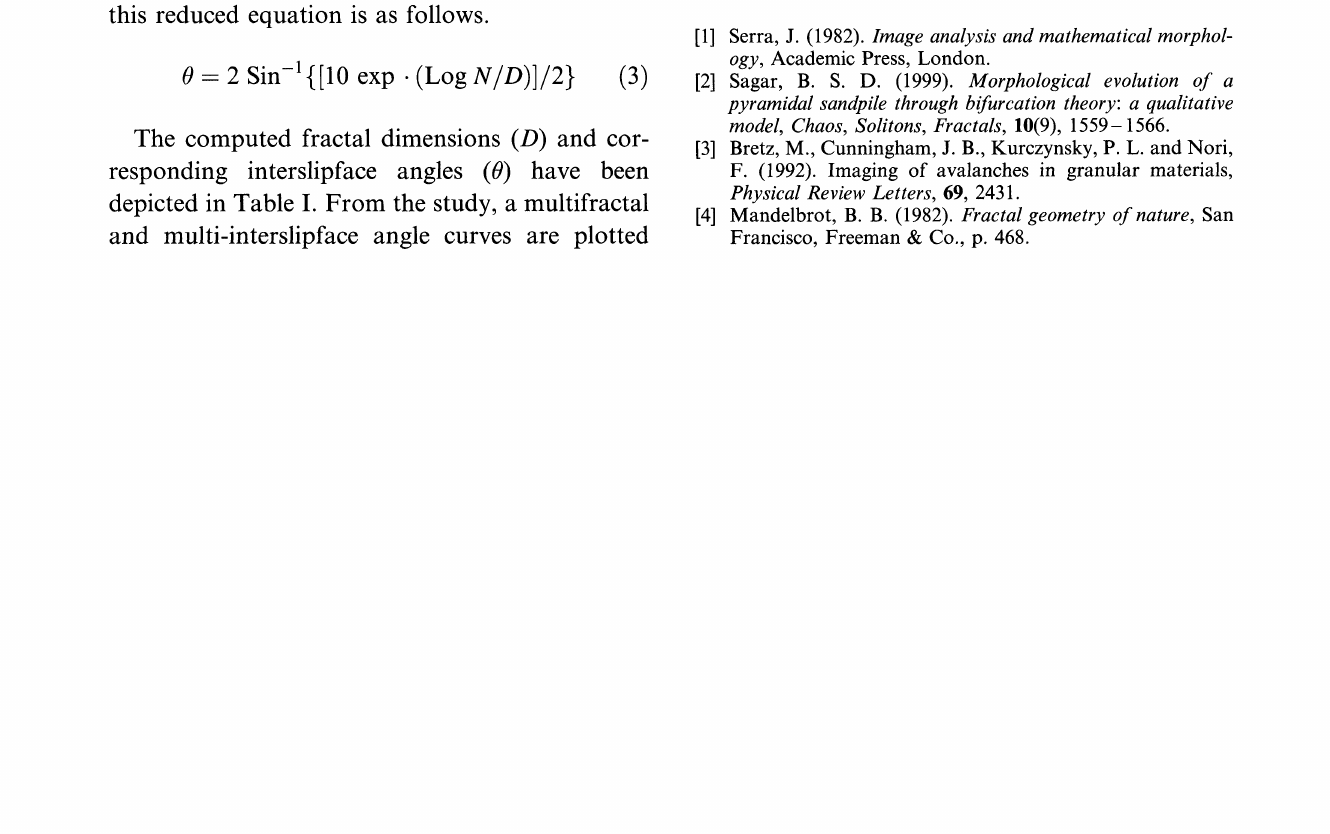
number of slipfaces (N= 2 in the present context, and the normalized fractal dimension (c0). Now this reduced equation is as follows.